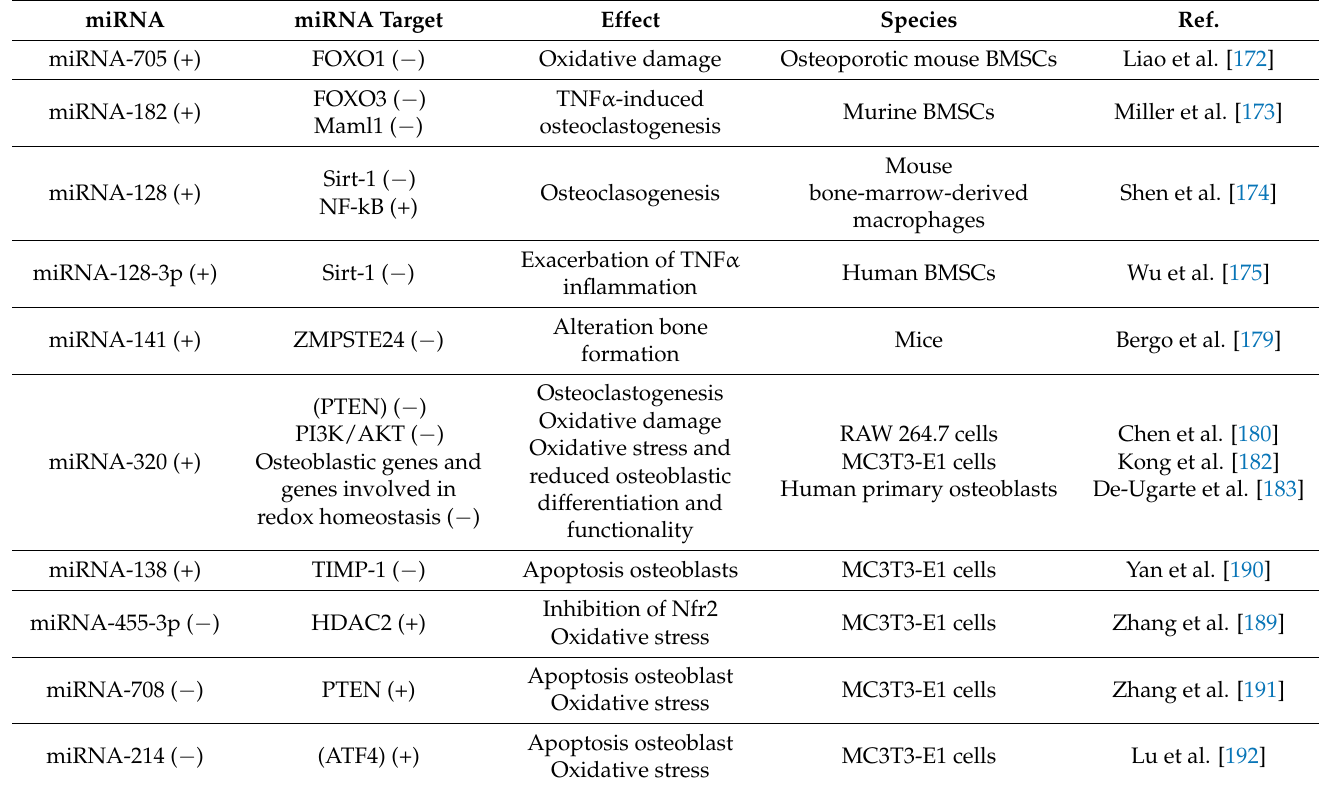
Table 1. Principal miRNAs related to oxidative stress and inflammation in